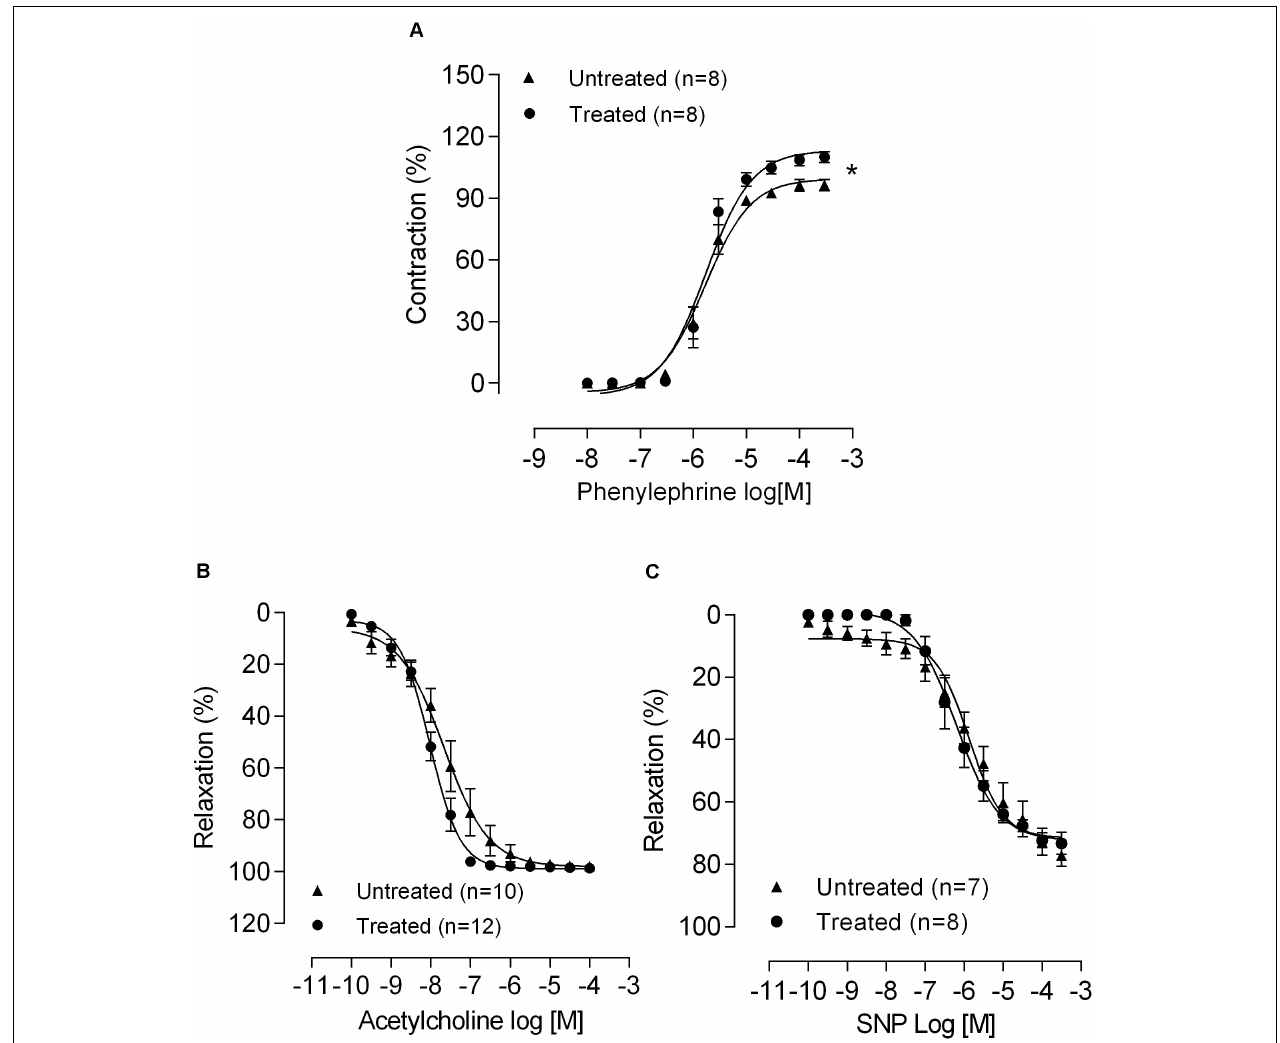
FIGURE 1 | Chronic lead treatment affects MRA reactivity. The effects of 30 days of exposure to lead on the concentration-response curves to (A) phenylephrine, (B) acetylcholine, and (C) sodium nitroprusside (SNP). Data are expressed as the mean ± SEM. * P < 0.05 versus untreated using two-way ANOVA and Bonferroni post hoc test. n denotes the number of animals